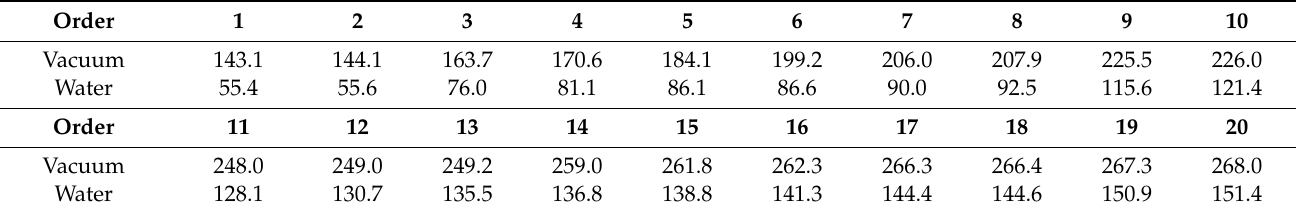
Table 1. Natural frequency in different